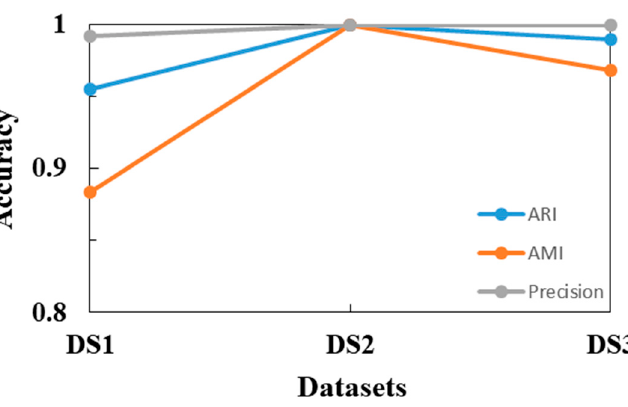
Figure 7. The accuracy values of SCMDOT in Experiment 1 .